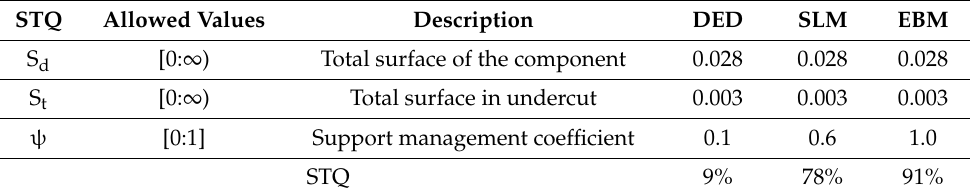
Table 7. Study of the undercuts (STQ) calculation for the FDM head for traditional plastics.